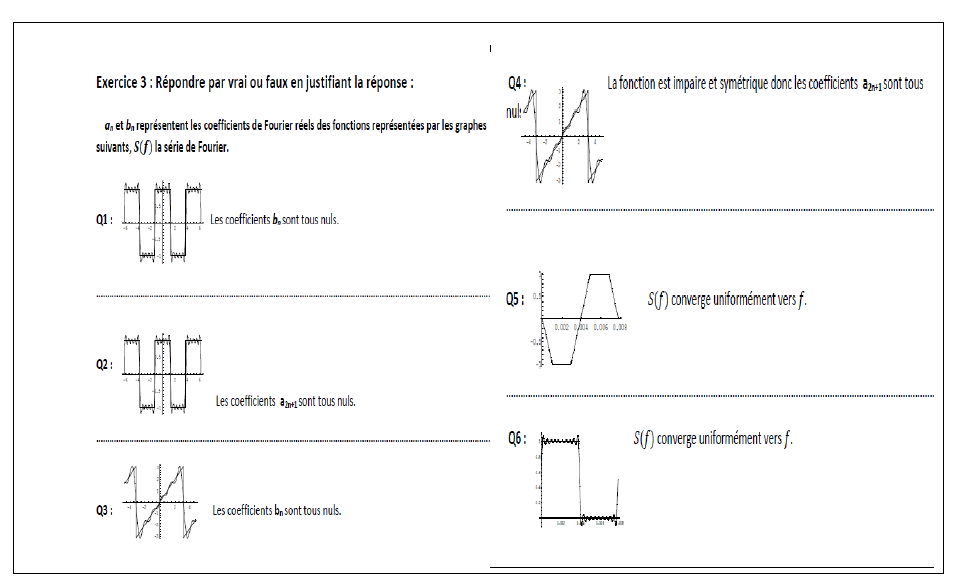
Fig. 2. Enoncé de l’exercice 3 du questionnaire final. Notons que seuls 60 étudiants parmi les 64 ont passé le questionnaire final (les quatre